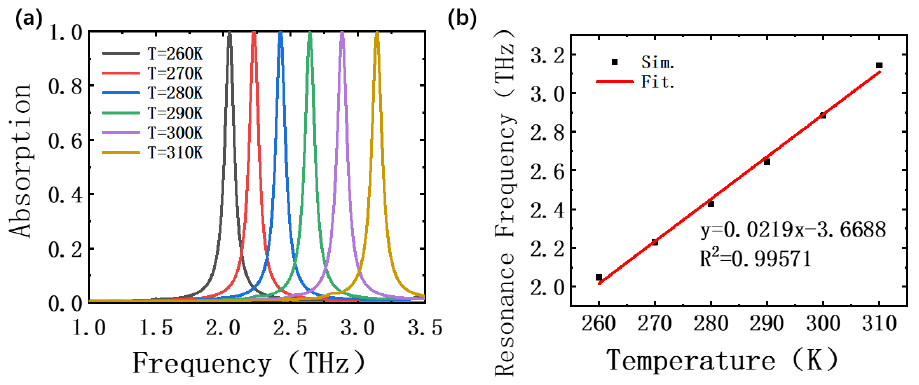
Figure 8. ( a ) Absorbance spectra of the designed PMMA with different temperatures T , ( b ) the simulated resonance frequencies (black squares), and the fitting curve (solid red line) as a function of external temperature T . Table 1. Compare the previously reported sensor with the proposed sensor.